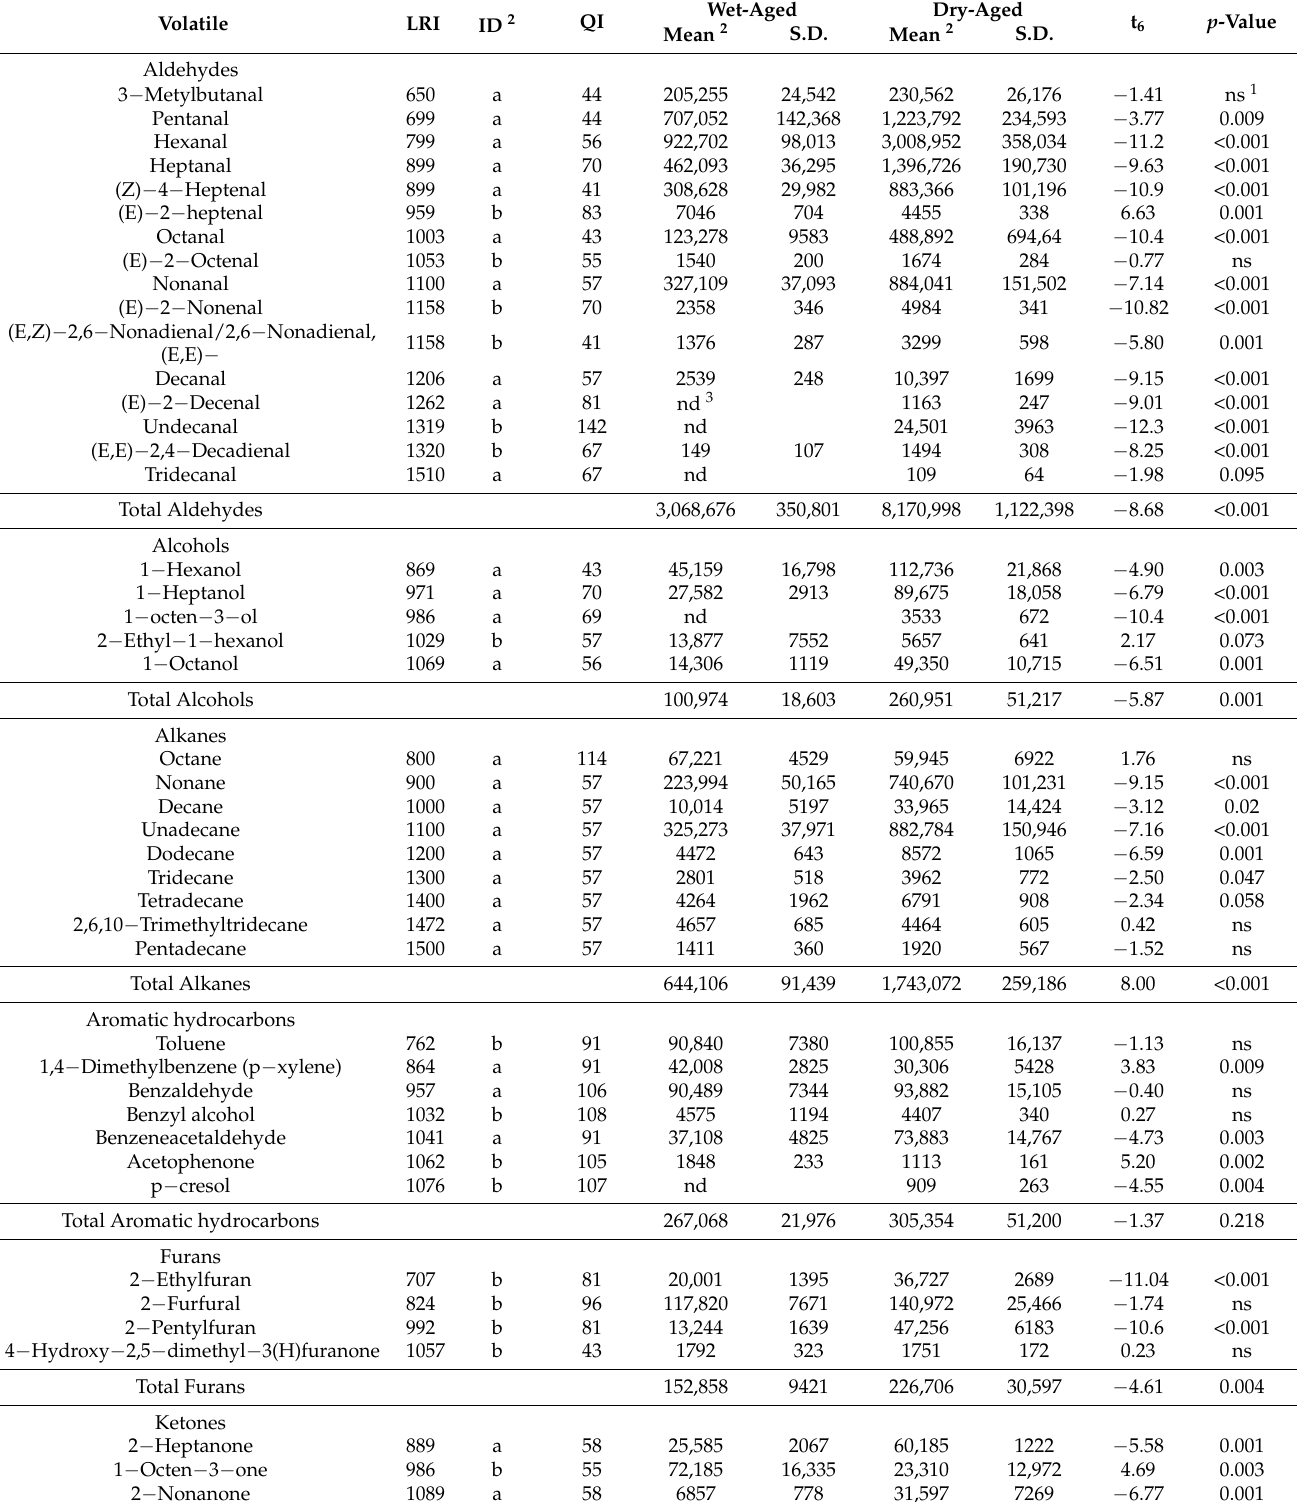
Table 6. Effect of ageing method (dry vs. wet) on volatile concentrations (ng/g) 1 for cooked mutton patties; standard deviation (S.D.), t-value (t) with subscript degrees of freedom, level of significance ( p -value), the experimental Kovats retention indices (LRI), the identification method (ID) and quantification ion (QI) are